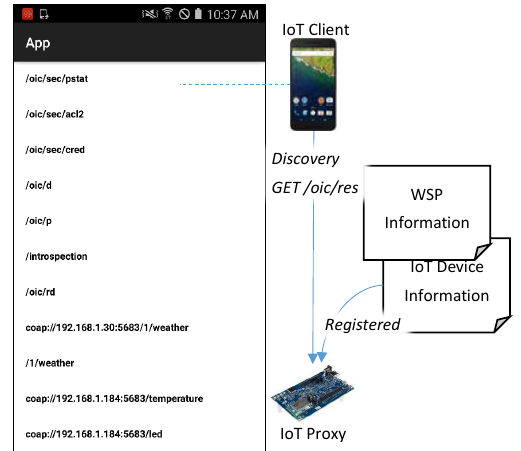
Figure 13. Fragment of RAML definition for registering WSP.